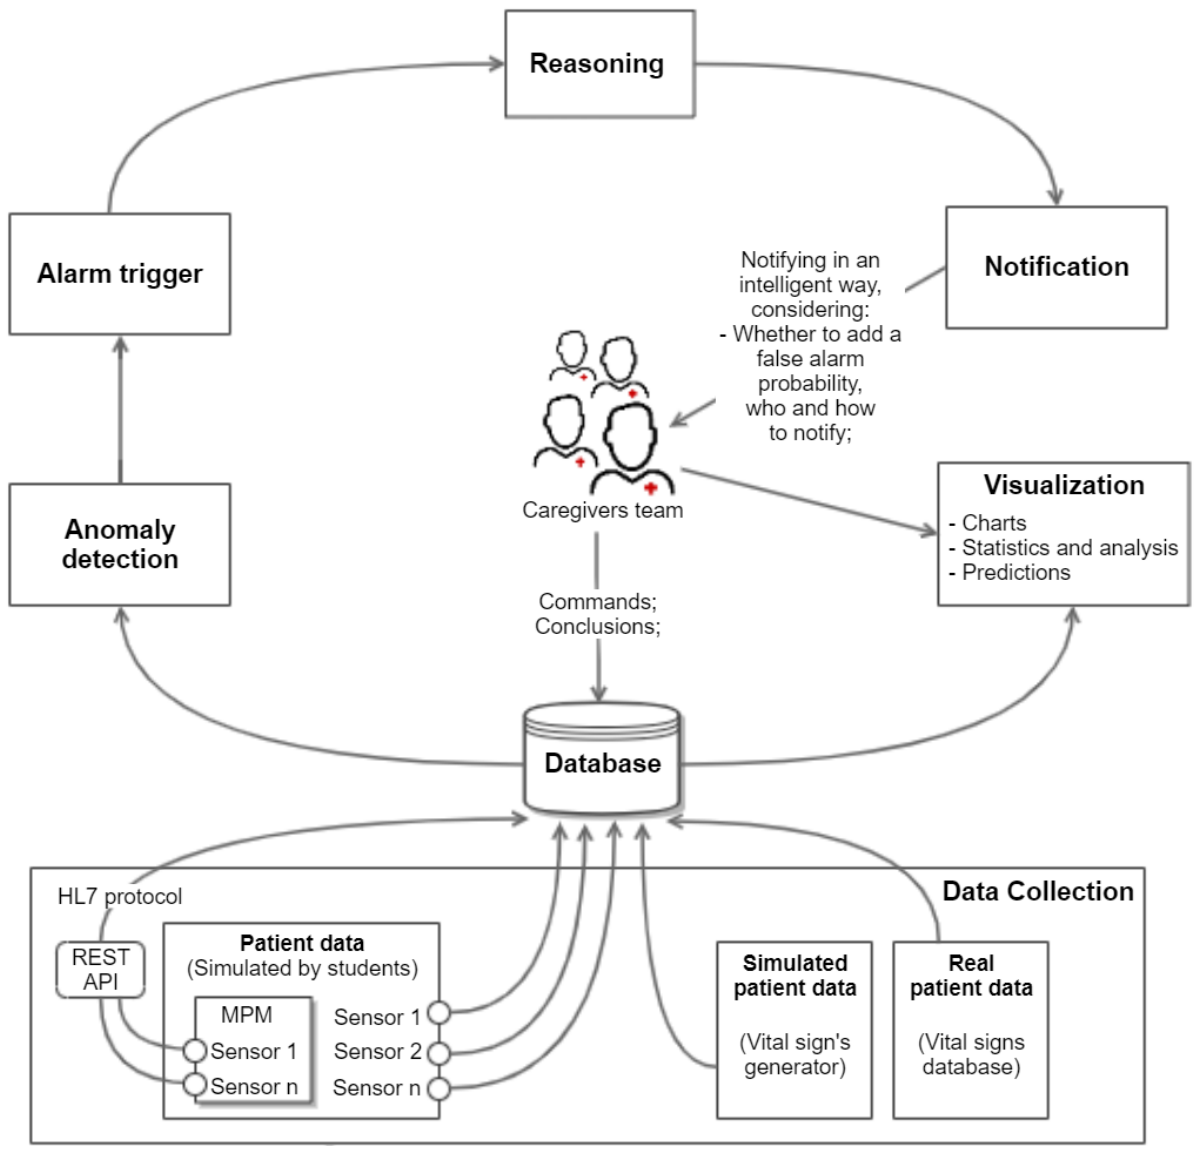
Figure 3. An architecture designed for health care systems that support patient monitoring and notification capabilities. MPM: Multi-parametric Monitor; API: Application Programming